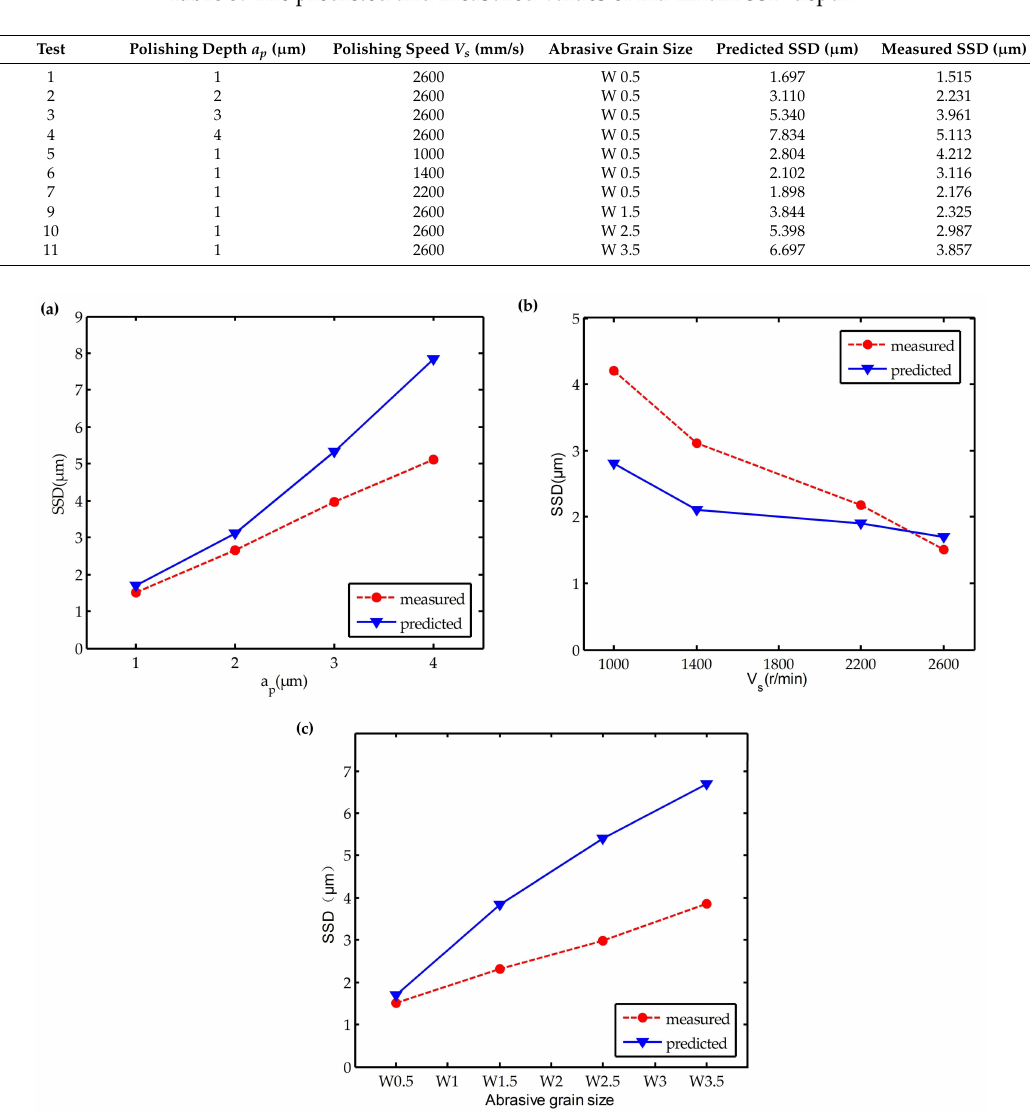
Table 5. The predicted and measured values of maximum SSD depth.